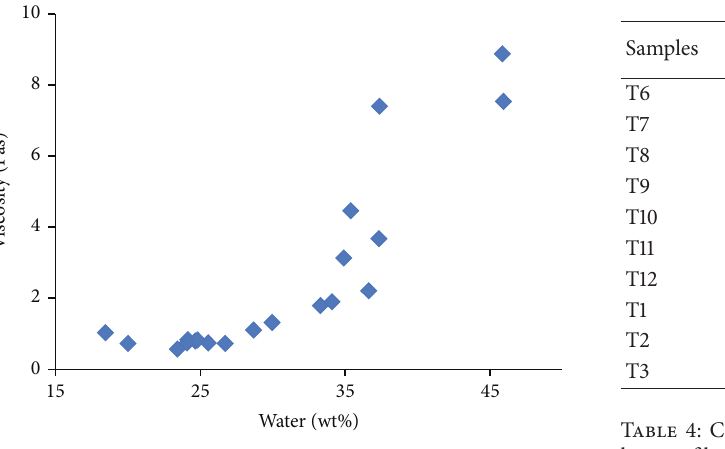
Table 4: Composition percentage, lipid/AP, and contact angle